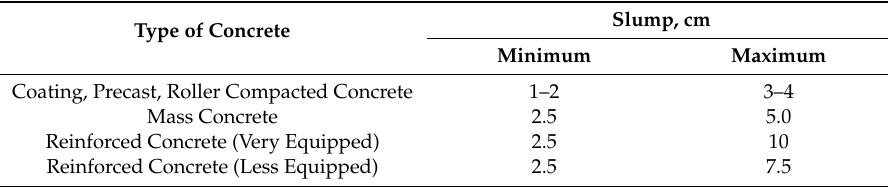
Table 18. Coating concrete slump values.